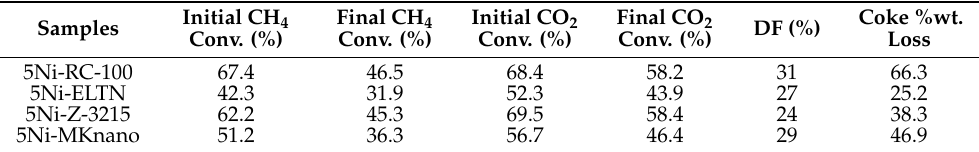
Table 3. Conversions of CH 4 and CO 2 , deactivation factor, coke formed.